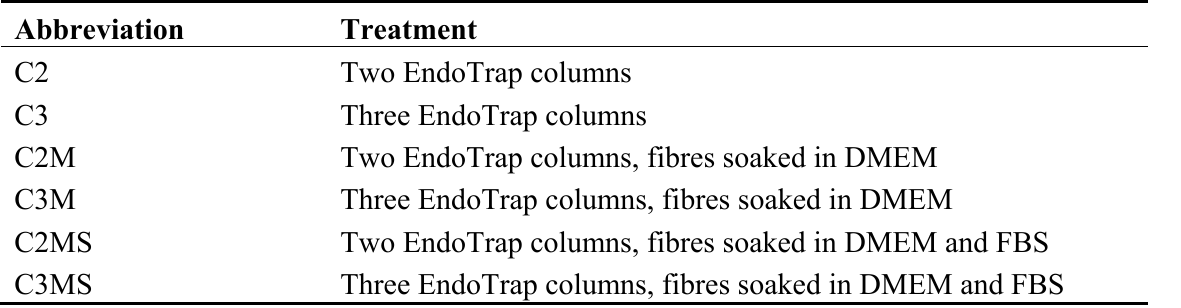
Table 1. Different treatments of 4RepCT before implantation. Abbreviations: Dulbecco’s Modified Eagle’s Medium (DMEM), and Fetal Bovine Serum